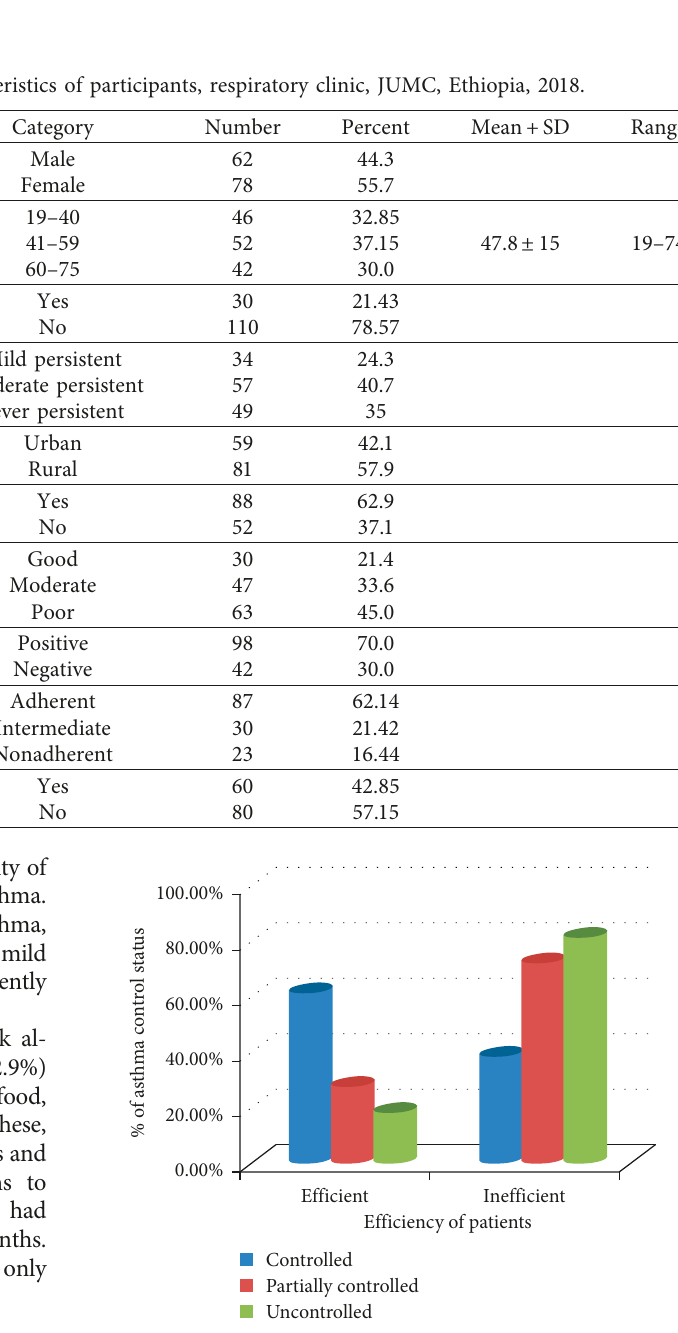
Figure 2: The relationship between inhalation technique and asthma control status, respiratory clinic, JUMC, Ethiopia,